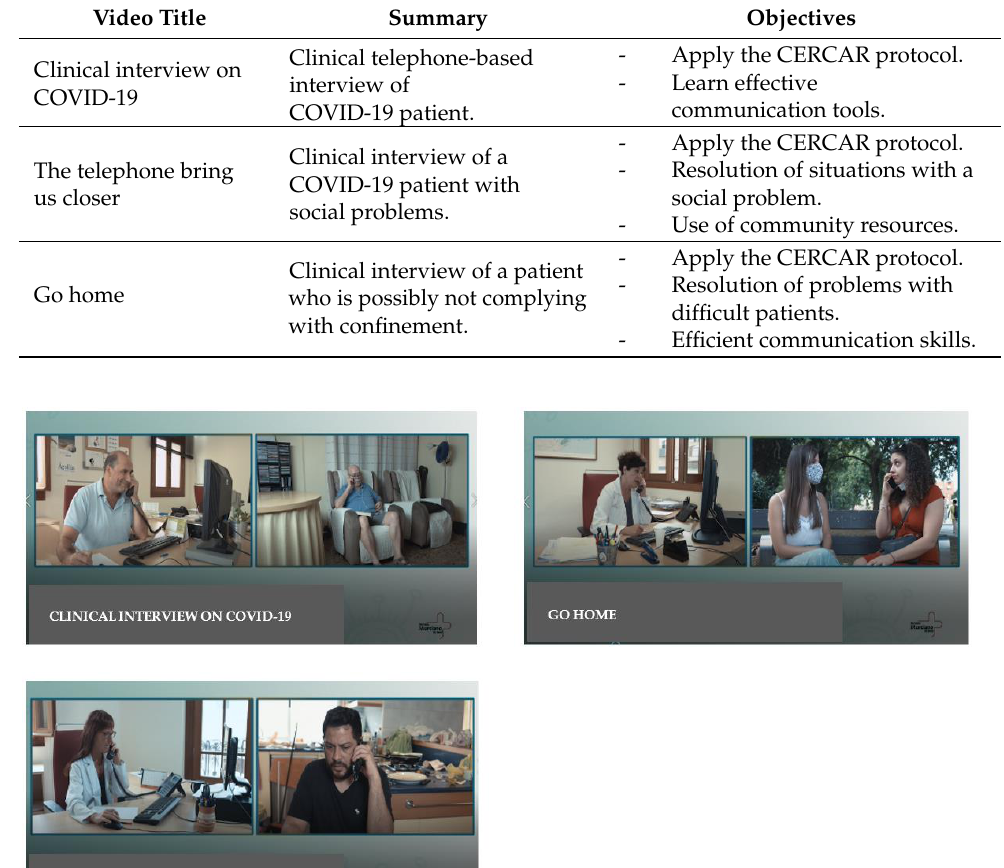
Table 2. Teaching/problem videos of clinical cases of monitoring and follow-up of COVID-19 patients.